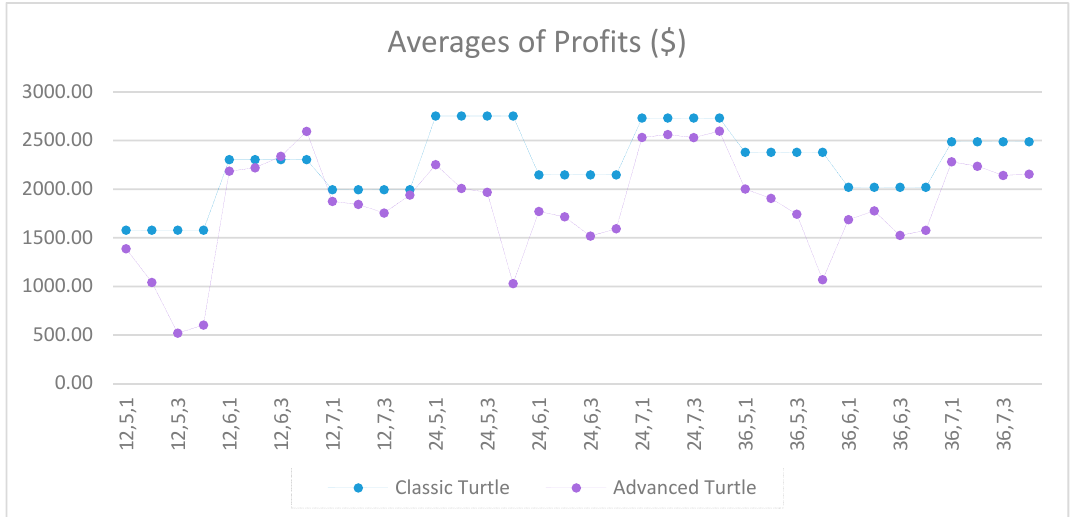
Figure 14. Averages of drawdowns as percentage of equity between the classic and the advanced Turtle systems for every combination of N, X, Y for the slow parameters (80, 160).